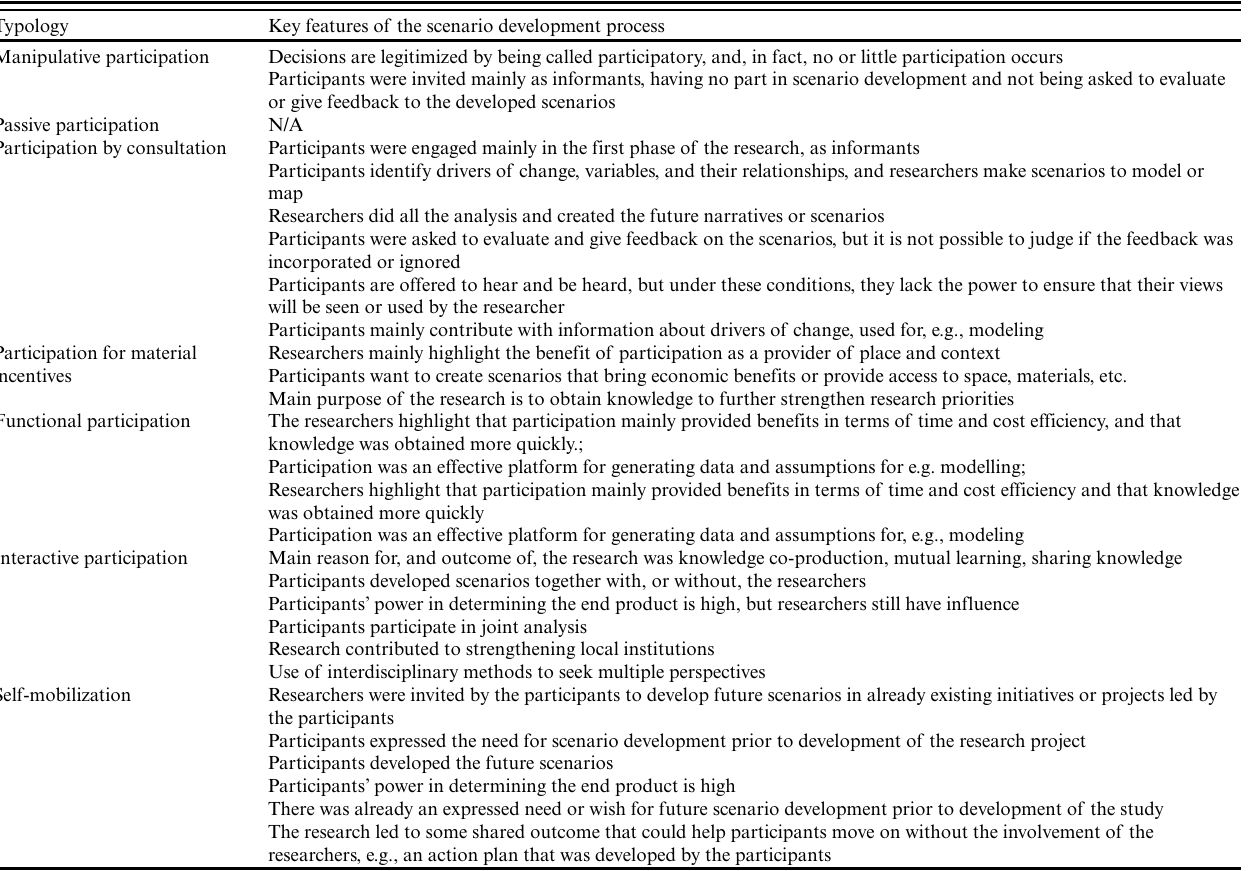
Table 4. Pretty’s (1995) typology in the context of key features of the participatory scenario development process, based on the reviewed